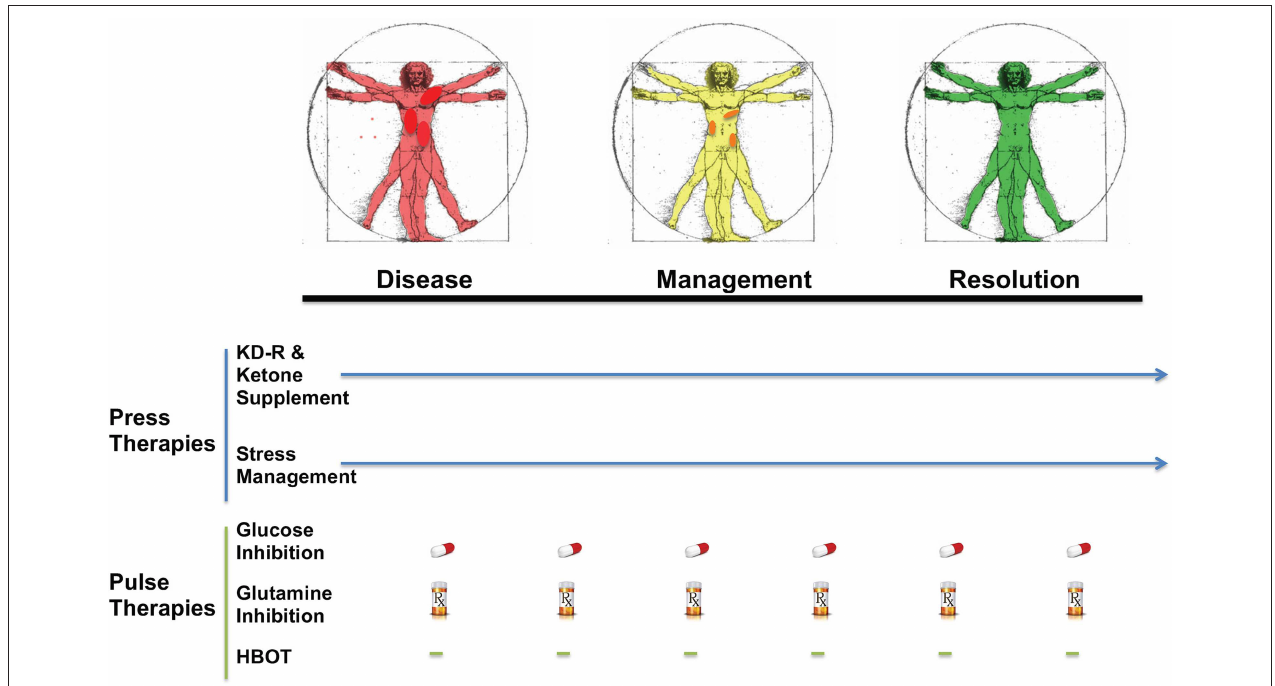
FIGURE 5 | Breast Cancer Management with Press-Pulse Therapeutic Strategy. Arens and West considered the simultaneous occurrence of “Press-Pulse” disturbances as the mechanism responsible for the mass extinction of organic populations during prior evolutionary epochs ( 213). We described how this concept could be adopted as a therapeutic strategy for the management and possible eradication of cancer (34). This therapeutic strategy considers all cancer, including breast cancer, as a single disease that can be managed by transitioning the energy metabolism of normal cells from glucose to non-fermentable ketone bodies, while simultaneously restricting the availability of fermentable fuels (glucose and glutamine) to tumor cells (34). The reduction in blood glucose levels will also reduce insulin and insulin-like growth factor 1, which are known to drive rapid tumor growth (184, 214, 215). This metabolic therapeutic strategy exploits the dependency of tumor cells on glucose and glutamine fermentation and their inability to metabolize ketone bodies for energy due to defects in the number, structure and function of the tumor mitochondria. In essence, the press-pulse therapy pits the metabolic demands of the mutated tumor cells against those of the normal cells, which evolved to adapt and survive under the extremes of nutrient stress (216). Collections of random mutations will prevent tumor cells from adapting to nutrient stress, thus leading to their extinction according to evolutionary theory (81). As a cancer diagnosis can increase emotional stress and blood glucose, stress management techniques together with exercise could improve general health while reducing glucose availability to the tumor. The press therapies would work synergistically with acute pulse therapies to further restrict glucose and glutamine metabolism. HBOT would work synergistically with the press therapies to increase oxidative stress selectively in tumor cells. The timing (spacing) between the various pulse therapies is designed to stress tumor cell metabolism while minimizing toxicity to normal body cells (34). This therapeutic strategy will target the fermentation metabolism common to most breast tumor cells, thus degrading tumor burden gradually with little or no toxicity. The color change from red (diseased with darker red spots indicative of metastatic lesions), to yellow (with reduced metastasis), to green (resolution) in the Vitruvian man indicates the gradual metabolic management and possible resolution of the breast cancer. The pill and Rx symbols are suggestive of drugs taken orally and/or intravenously (prescription) that would be effective in targeting simultaneously glycolysis and glutaminolysis. Pulse therapies would be eliminated with evidence of tumor management or resolution, while press therapies could continue under modifications or adjustments (arrow). Optimization of timing, dosing, and scheduling of the press-pulse treatments will facilitate eradication of tumor cells with minimal patient toxicity. This therapeutic strategy is a framework for future clinical trials. HBOT, hyperbaric oxygen therapy; KD-R, calorie restricted ketogenic diet. The figure is reprinted with modifications, as described previously (34) and distributed under a Creative Commons